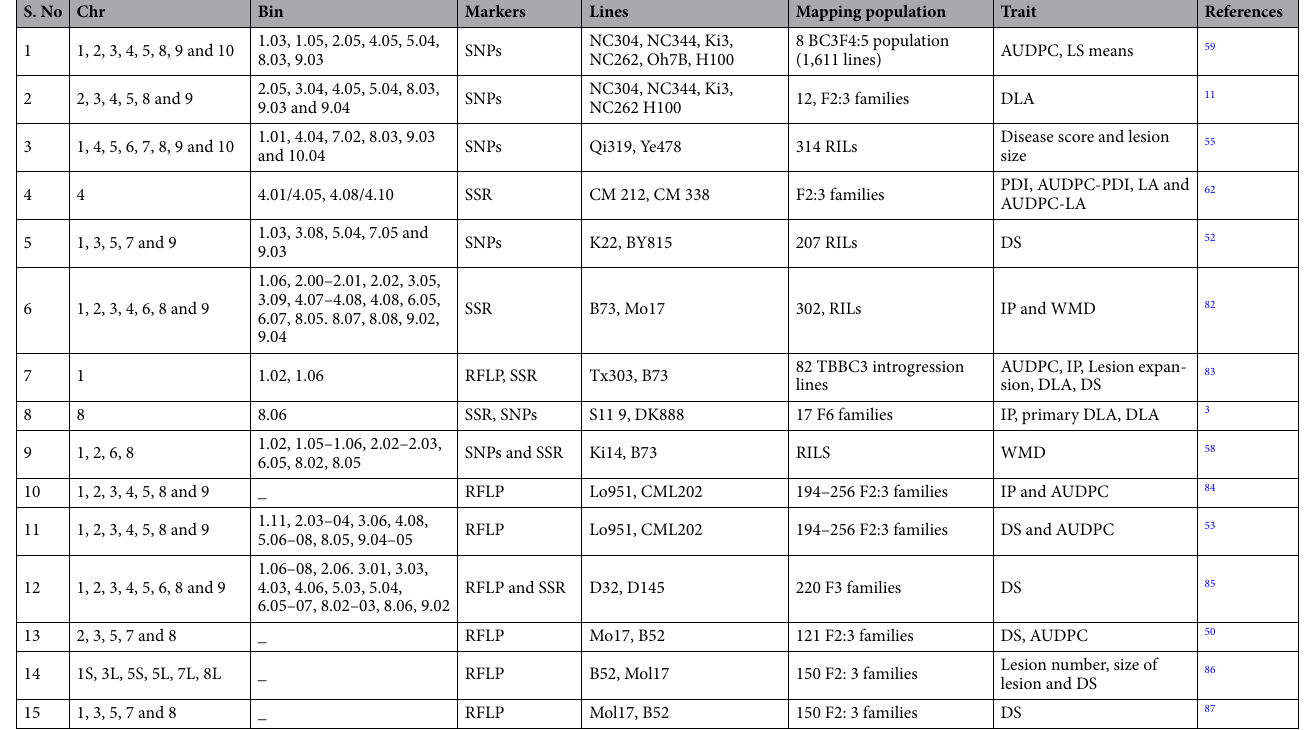
Table 1. Summary of selected genetic mapping studies for NCLB resistance using different mapping populations in various genetic backgrounds. Molecular markers used in these studies were Single nucleotide polymorphism (SNPs), Simple sequence repeats (SSR), restricted fragment length polymorphism (RFLP), cleaved amplified polymorphic sites (CAPS). Phenotypic traits like area under disease progress